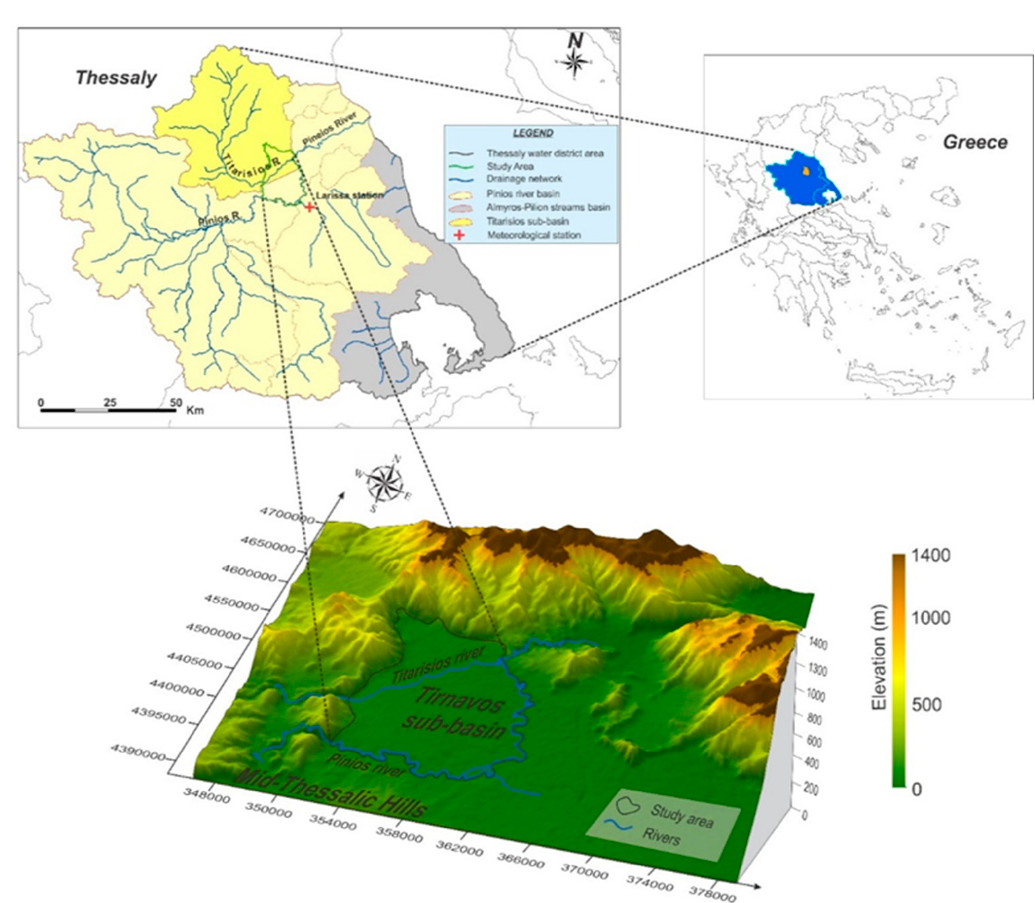
Figure 1. Location map of the study area and geomorphological illustration of the wider region.